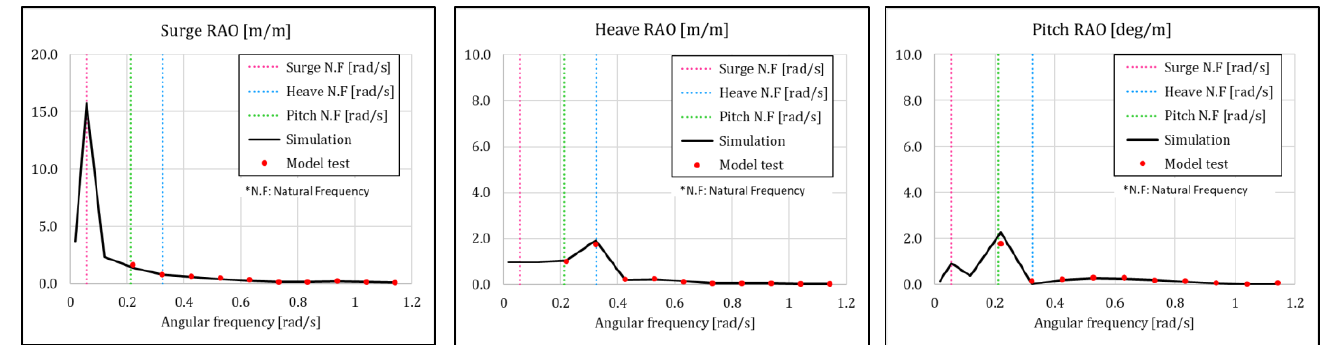
Figure 8. LC1 RAO result under no wind and regular waves.